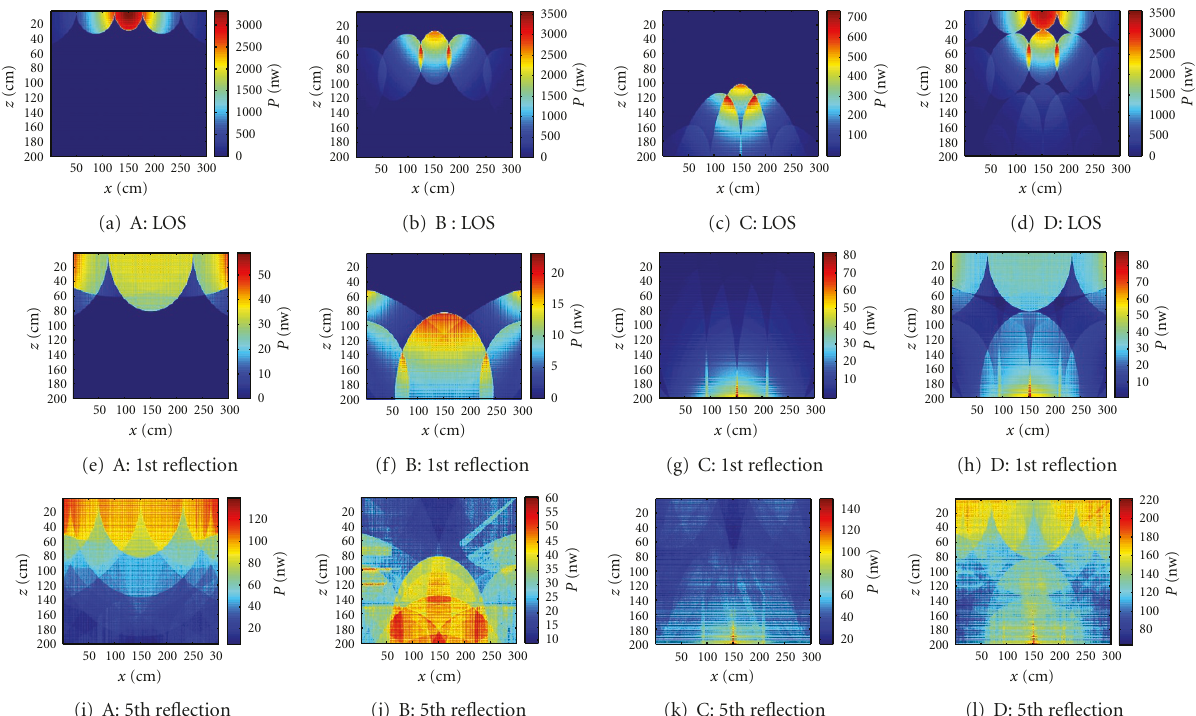
(l) D: 5th reflection Figure 8: Simulation results of surface power illumination pattern for configurations A, B, C, and D (from left to right in each row): (a)–(d) for LOS path, (e)–(h) for the first bounce of reflection on the wall, and (i)–(l) for the fifth bounce of reflection on the wall. Table 2: Simulation parameters for five configurations of multibeam transmitters.